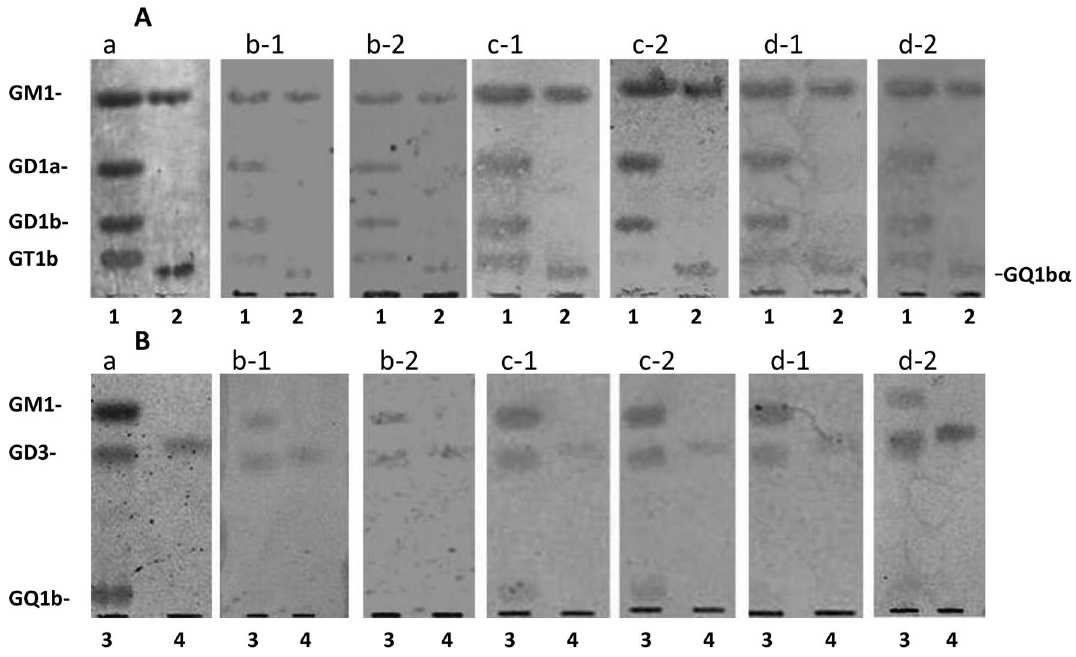
Figure 2. HPTLC-immunostaining of brain gangliosides, such as GM1, GD1a, GD1b, GT1b, and GQ1b a (plate A) and GM1, GD3, GQ1b, and SGPG (plate B). Lane 1, 1 m g each of GM1, GD1a, GD1b, and GT1b; 2, 1 m g of GM1 and GQ1b a ; 3, 1 m g each of GM1, GD3, and GQ1b; and 4, 1 m g of SGPG. a, orcinol sulfuric acid staining; b, c, and d, immunostaining; b-1 and b-2, control sera; c-1 and c-2, AD sera (Alzheimer’s disease); d-1 and d-2, VD sera (vascular dementia). Plates A and B were developed with CH 3 Cl 3 :CH 3 OH:0.2%CaC 2